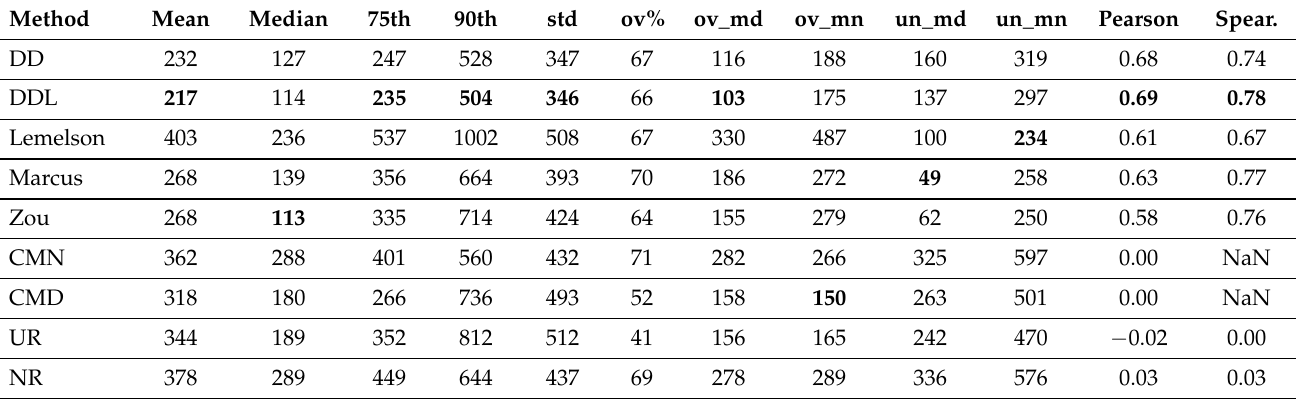
Table 4. The performance of all studied methods and baselines, based on various evaluation metrics, on the validation set of the Sigfox dataset. The first five columns report statistics ( mean, median, 75th percentile, 90th percentile, and standard deviation ) of the absolute DAE error. The next column “ ov% ” describes the percentage of DAE overestimation (percentage of estimates where the actual location is “ inside the DAE circle ”). The mean and median DAE error of the overestimated estimates are reported under “ ov_ mn ” and “ ov_ md ”, respectively. The same statistics for the underestimation case are provided under “ un_ mn ” and “ un_ md ”, respectively. Lastly, Pearson’s correlation coefficient and Spearman’s (rank) correlation coefficient between the DAE values and the actual positioning errors are reported in the last two columns. The best performance for each metric is highlighted in